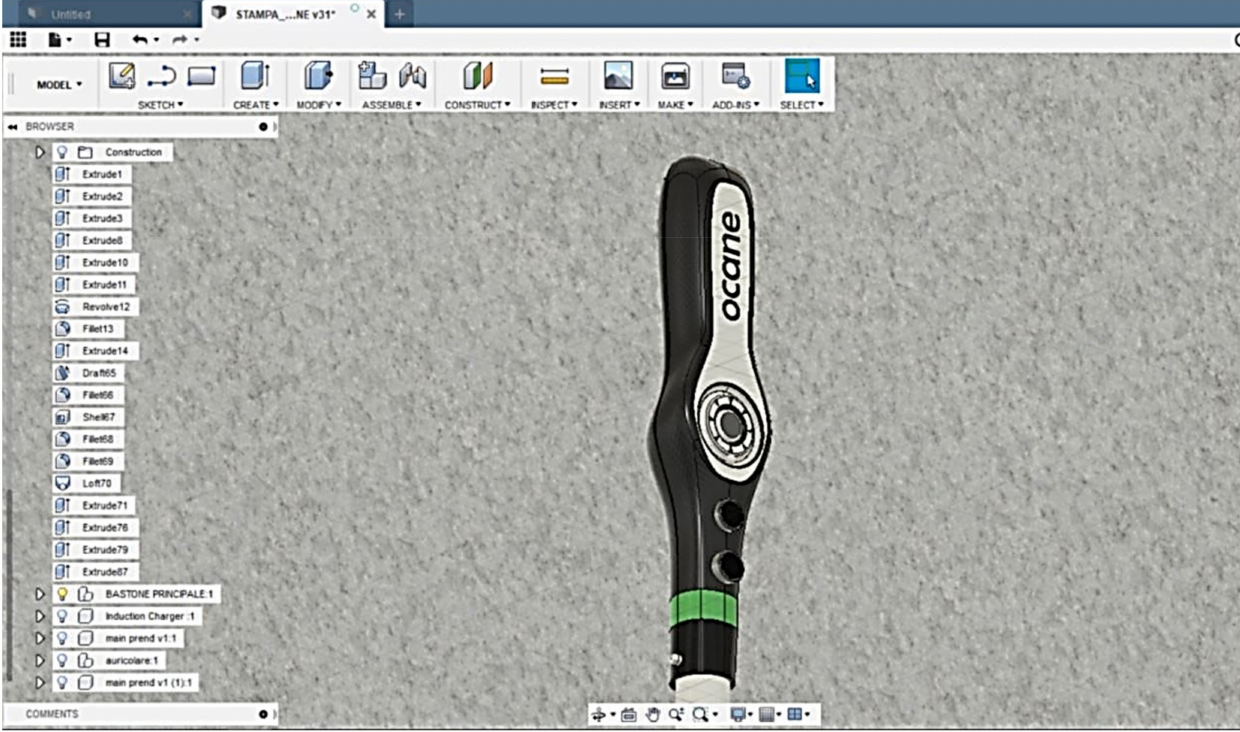
Figure 7. CAD modelling on Fusion